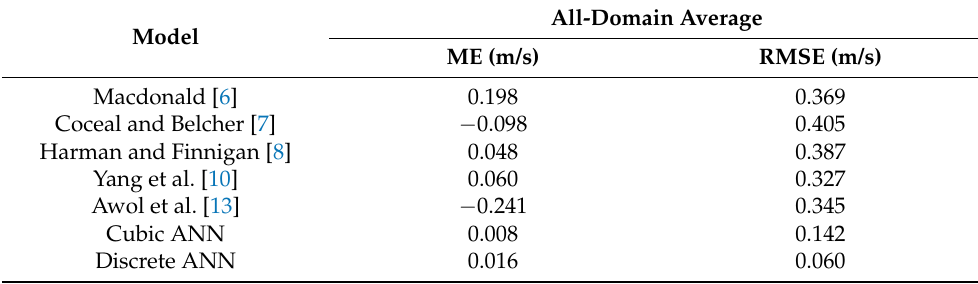
Table 10. Quantitative analysis of legacy models and ANN models from the current